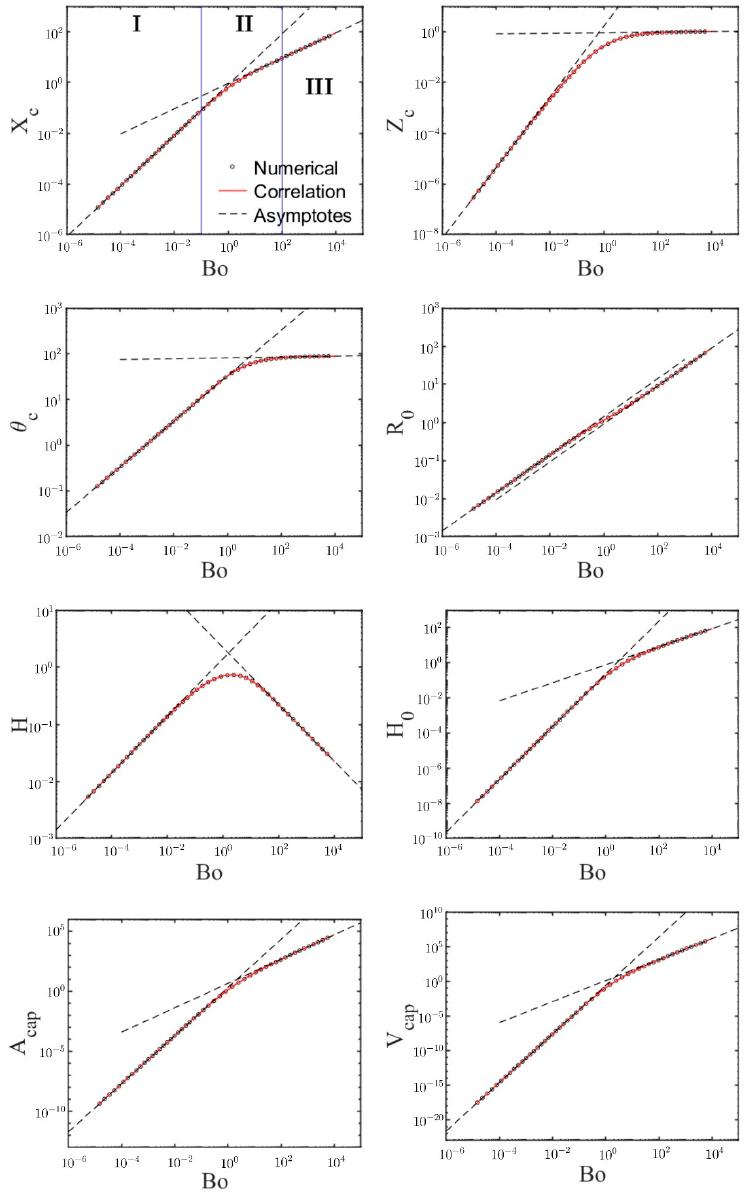
Figure 10. Correlation and two asymptotes of the computed bubble parameters as a function of the Bond number on a log–log scale. The correlation is given by a fifth-order polynomial function in each of the three Bond number regions (I, II, and III). The two asymptotes are given by a power law.